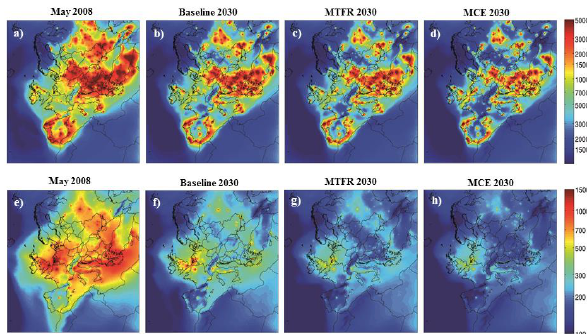
945 946 947 Fig. 1. Model simulations for 2008 and the baseline, MTFR, and 948 Fig. 1: Model simulations for 2008 and the baseline, MTFR, and MCE scenarios for 2030 for 949 MCE scenarios for 2030 for N tot (a–d) , and N 100 (e–h) . The con- N tot (a-d), and N 100 (e-h). The concentrations are mean values in each grid cell for the whole 950 centrations are mean values in each grid cell for the whole simula- simulation period. The colour bars indicate particle number concentration in # cm -3 . 951 952 tion period. The colour bars indicate particle number concentration 953 954 in # cm − 3 955 956 957